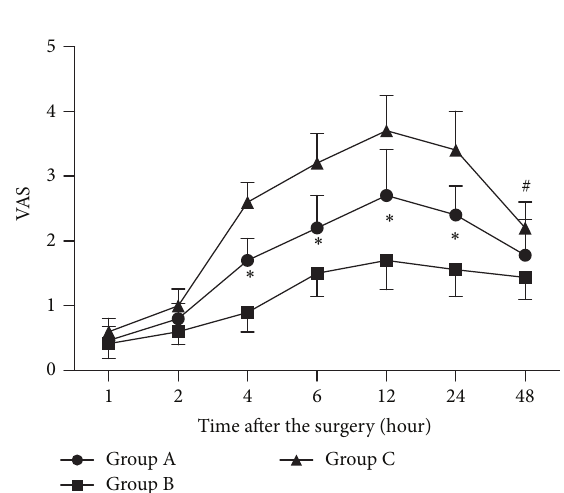
Figure 1: Visual analog pain scale: patients rated their levels of pain on the 0–10cm VAS (0cm = no pain to 10cm = the worst possible pain). ∗ 𝑃 < 0.05 versus other groups, # 𝑃 < 0.05 group C versus group